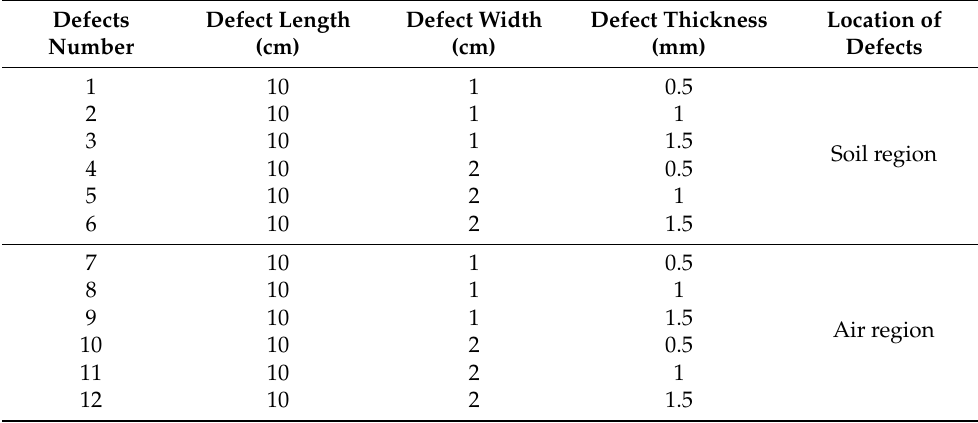
Figure 5. Cross-sectional view of two membranes: ( a ) profiles of defect 1 and defect 2 in Figure 4a; ( b ) profiles of defect 1, 2, and 3 in Figure 4b. Table 6. Dimensional details for defects shown in Figure Table 5. Dimensional details for defects shown in Figure 4a.